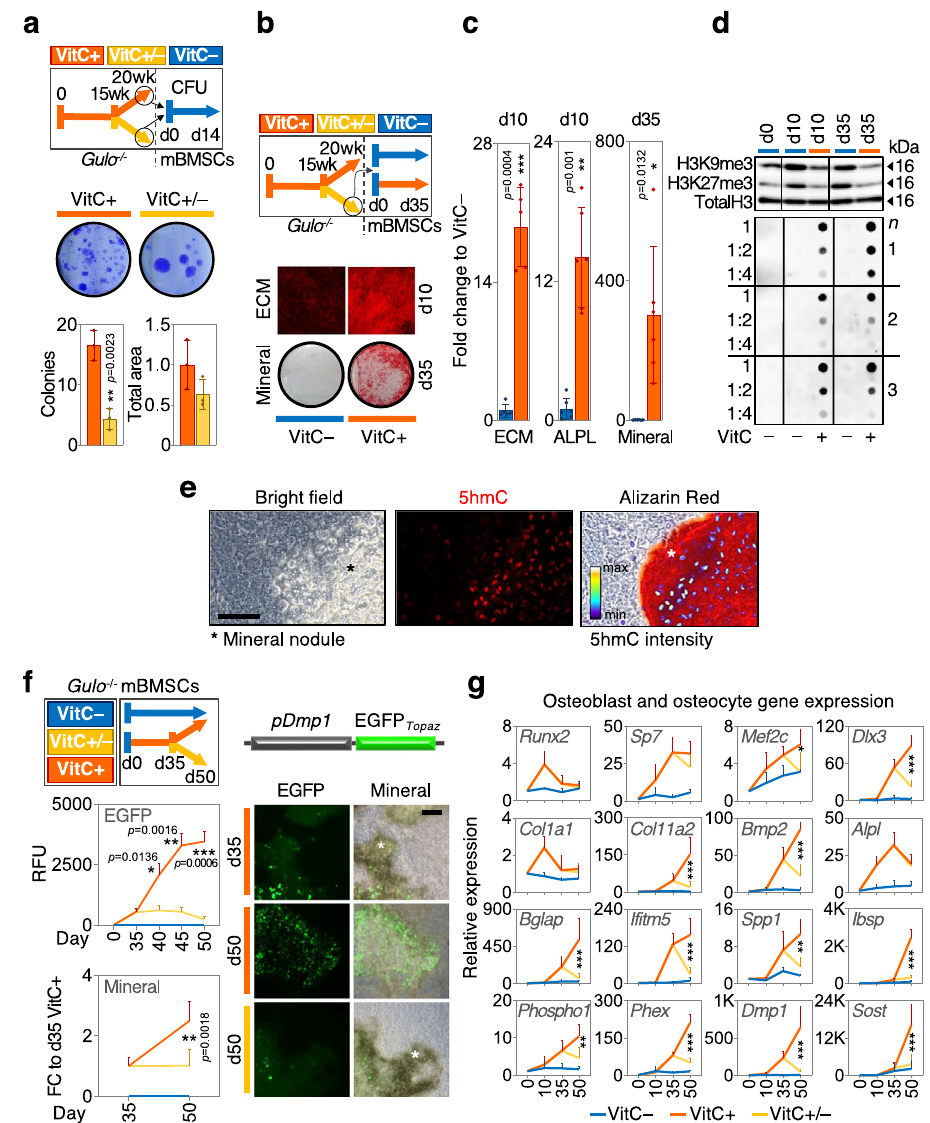
Fig. 4 | Vitamin C governs all differentiation stages of the osteogenic lineage. a Colonyformationunitassay(CFU)ofBMSCsisolatedfromVitCtreated(VitC+)or VitCdepleted (VitC ±) Gulo − / − micefrom week15 to week 20. b Extracellularmatrix (ECM) deposition and ECM mineralization in BMSCs isolated from VitC-de fi cient Gulo − / − mice. c QuantitationofECMdeposition,alkalinephosphataseactivity(ALPL) and ECM mineralization in VitC treated and untreated BMSCs. d Western blot for H3K9me3 and H3K27me3 and dot blot for 5hmC during osteogenic lineage pro- gression. e 5hmC immuno fl uorescenceand alizarin red stain in matureosteoblasts within mineralizing nodules (*). f Quanti fi cation of Dmp1 promoter activity (EGFP fl uorescent signal) and ECM mineralization in cultures in which VitC was removed after D35 and representative images from experiments quanti fi ed in the leftpanel. (*) mineralized nodules; BMSCs from Gulo − / − mice with Dmp1-EGFP Topaz reporter